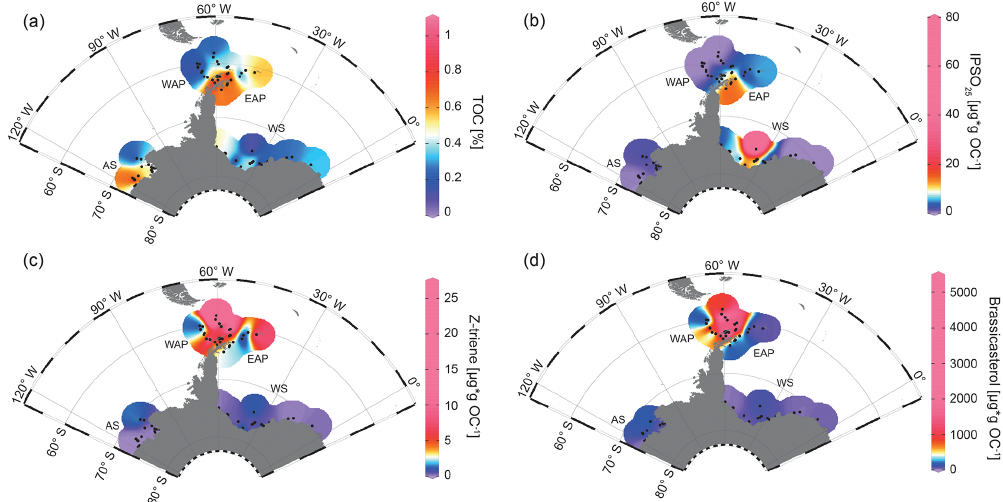
Figure 3. Distribution of (a) TOC (%), (b) IPSO 25 , (c) HBI Z-triene and (d) brassicasterol in surface sediment samples. Sample locations are marked as black dots. Concentrations of biomarkers (µggOC − 1 ) were normalized to the TOC content of each sample. The abbreviations used in the figure are as follows: AS – Amundsen Sea, WAP – West Antarctic Peninsula, EAP – East Antarctic Peninsula and WS – Weddell Sea. Maps were generated using the Ocean Data View Software (Schlitzer,